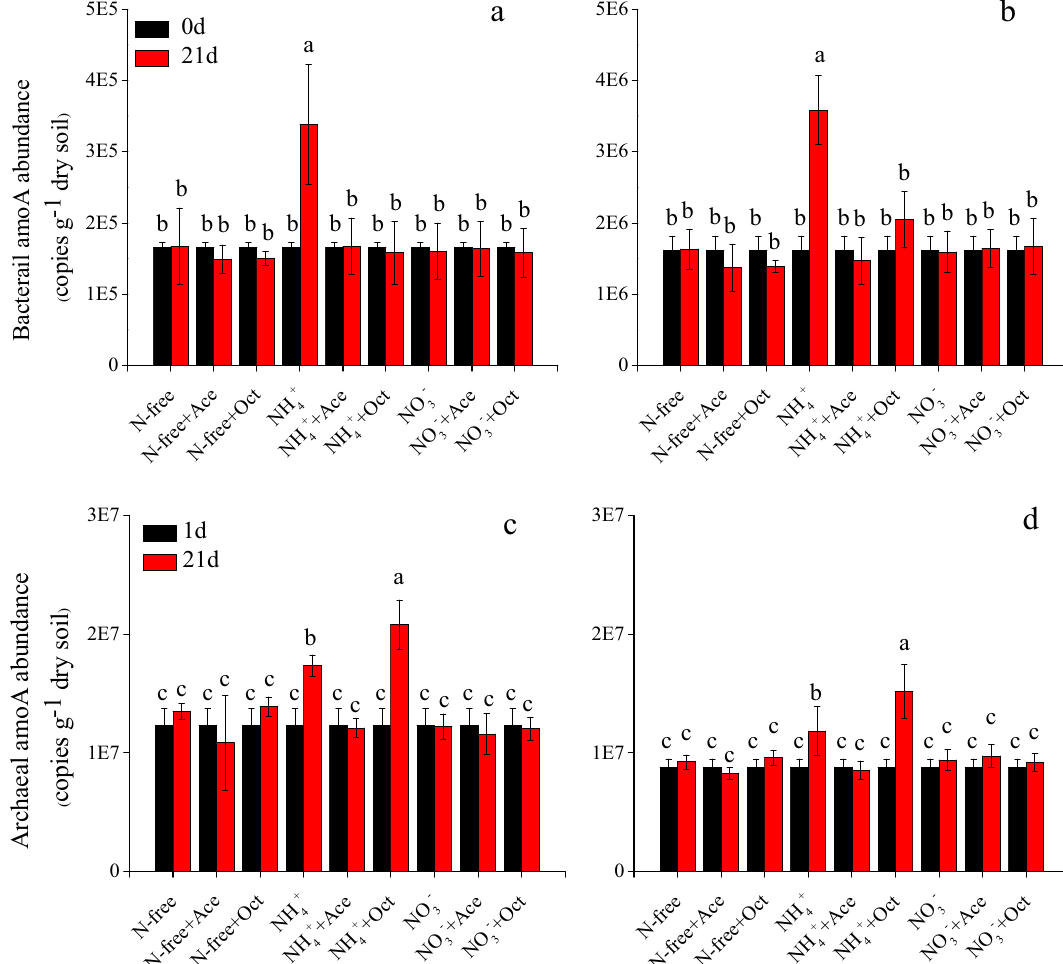
Figure 5. The AOB and AOA amoA genes abundance at 0 and 21 days of incubation in SX ( a and c ) and PL ( b and d ) soils; Different letters above the bars denote significant difference and the same letters denote no significant difference and error bars represent standard errors of three biological